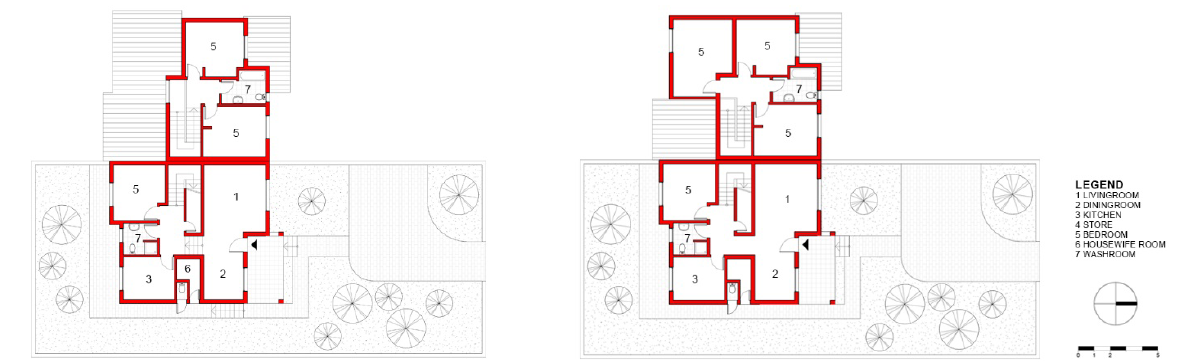
Figure 33. The Umudugudu Kigali 2020: Ground and first floor twin house types 2 and 1. Drawing by Manlio